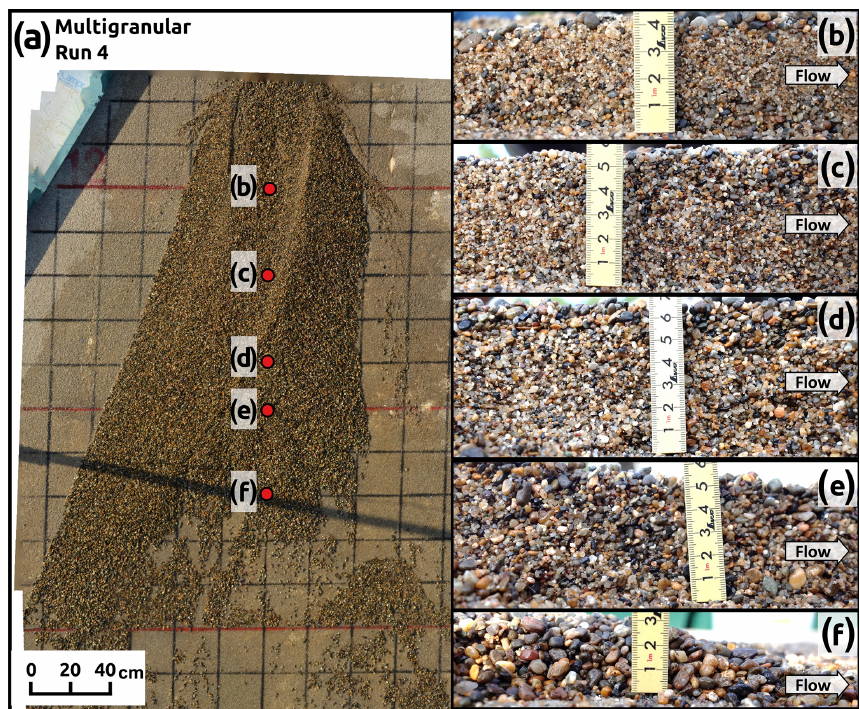
Figure 7. (a) Orthophoto of the debris-flow fan formed by the multigranular flow in test run 4. The red circles indicate the points at which the images were taken. Images of the longitudinal profile from the right-bank side view: (b) 1m downstream from the flume outlet (slope change point from 12 to 9 ◦ ), (c) 1.4m downstream from the flume outlet, (d) 1.8m downstream from the flume outlet, (e) 2m downstream from the flume outlet (slope change point from 9 to 6 ◦ ), and (f) 2.4m downstream from the flume